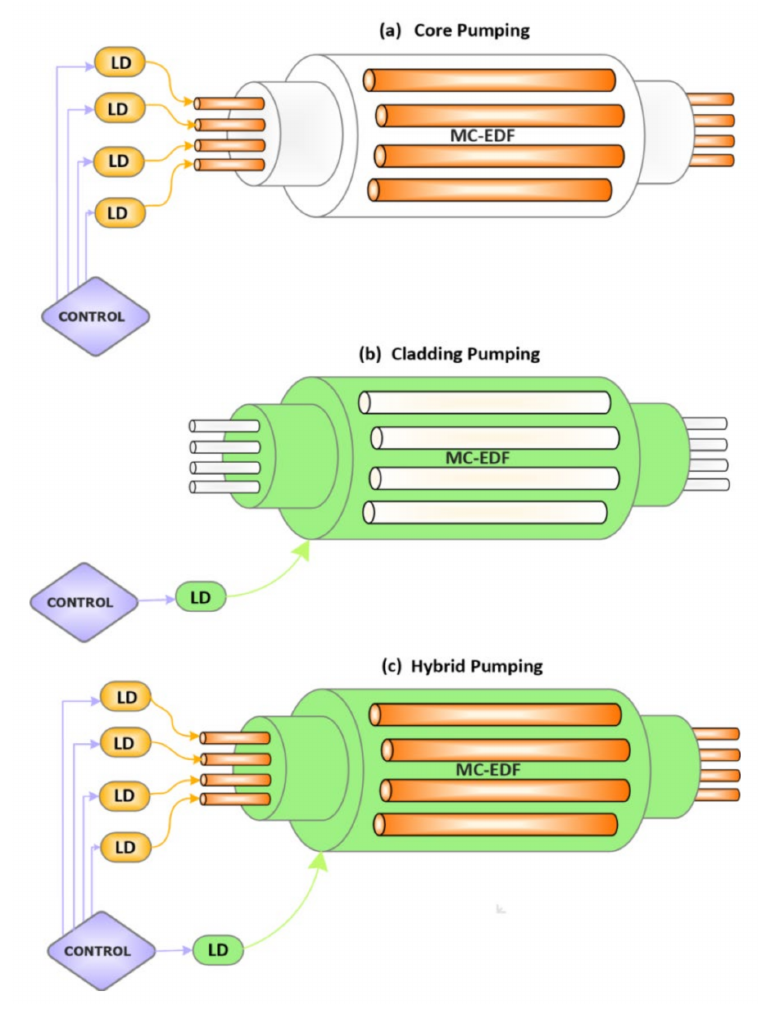
Figure 22. Pumping methods for MC-EDFA. ( a ) Core pumping. ( b ) Cladding pumping. ( c ) Hybrid